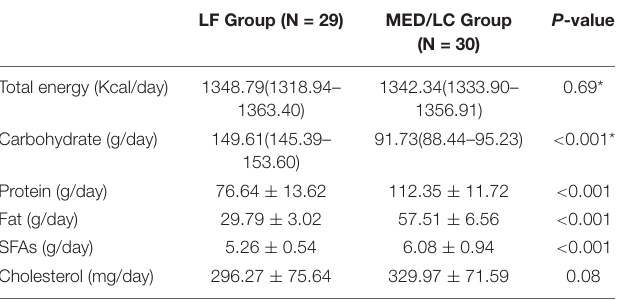
TABLE 2 | Dietary intakes of study participants throughout the